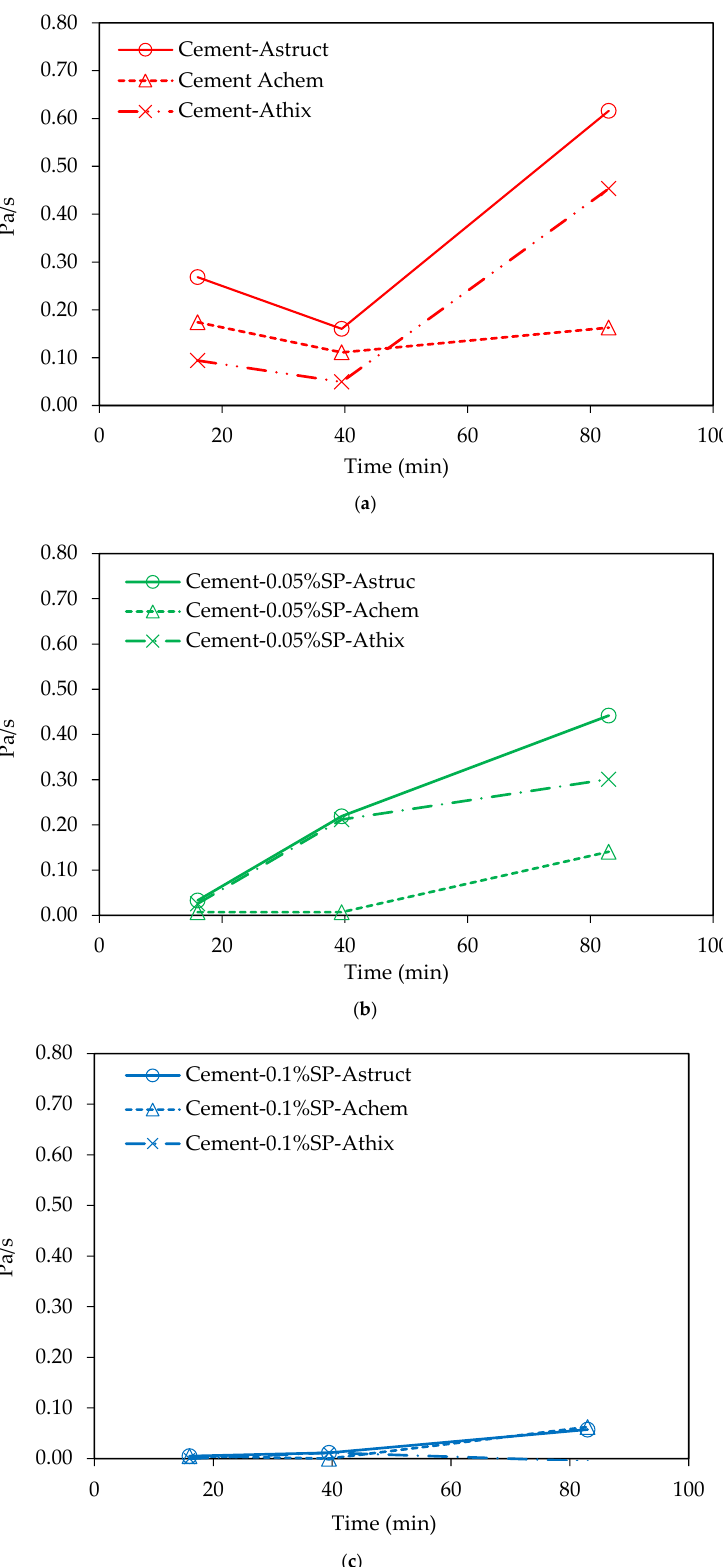
Figure 7. Evolution of the contribution of the structural build-up: ( a ) cement paste; ( b ) cement paste with 0.05% SP; ( c ) cement paste with 0.1% SP.